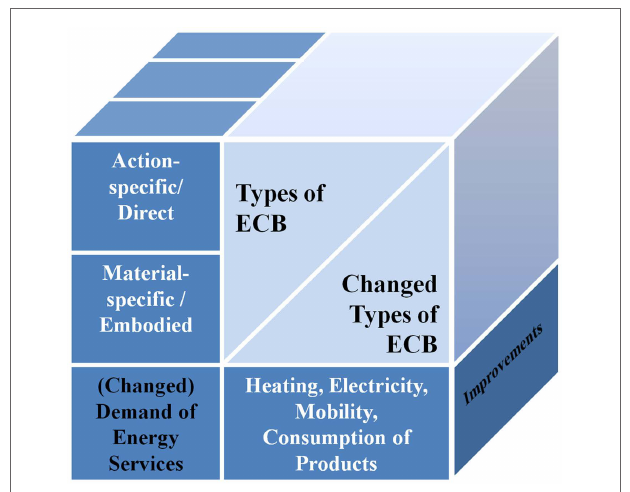
FiGUre 3 | explananda – types and changed types of eCB